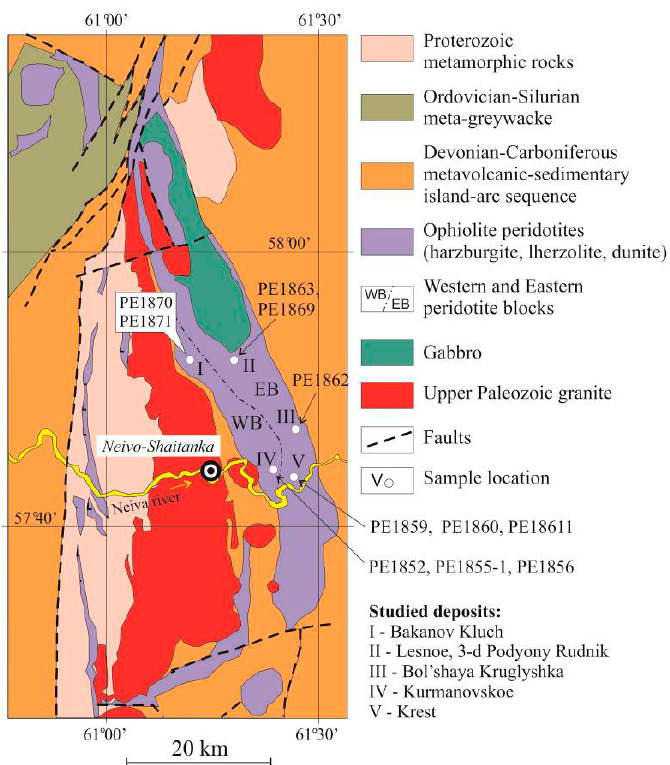
Figure 2. Simplified geological map of the Alapaevsk ophiolite massif showing the location of the chromite deposits, redrawn after [10].